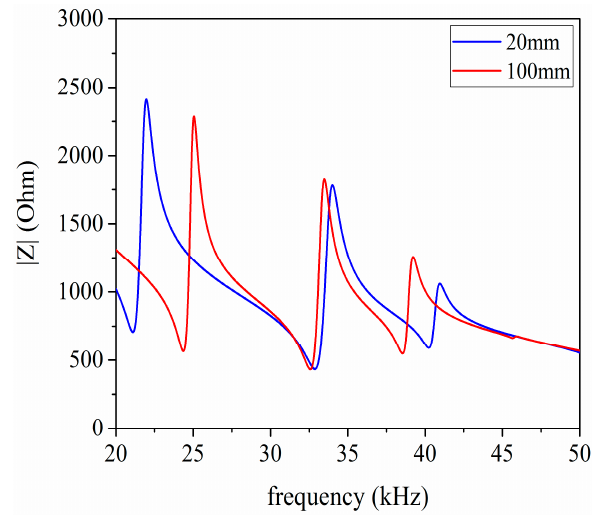
Figure 15. The impedance analysis of the pitch-catch setup.